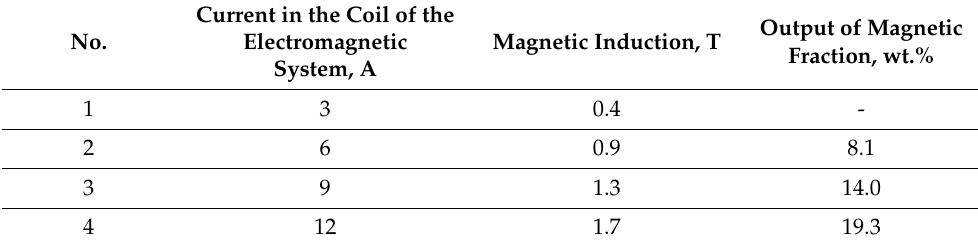
Table 4. Magnetic fraction output as a function of the magnetic field